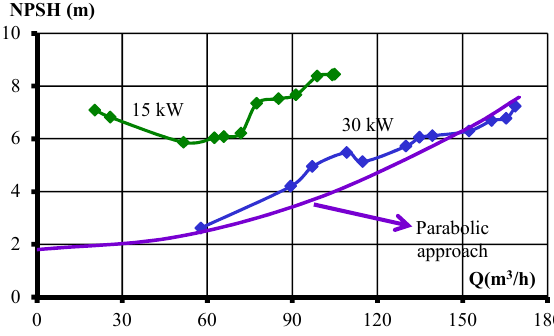
Figure 4. Comparison of the NPSH values for the two